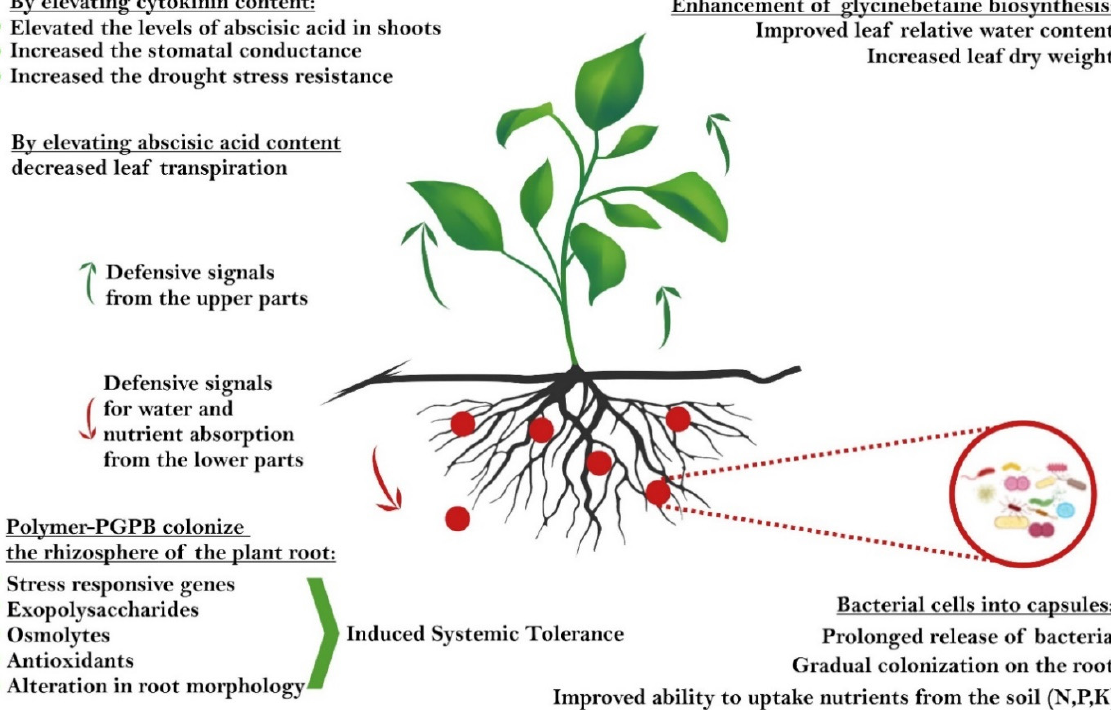
Figure 2. Schematic representation of the mechanism of action of polymer-PGPB soil inoculants for the protection of plants under drought